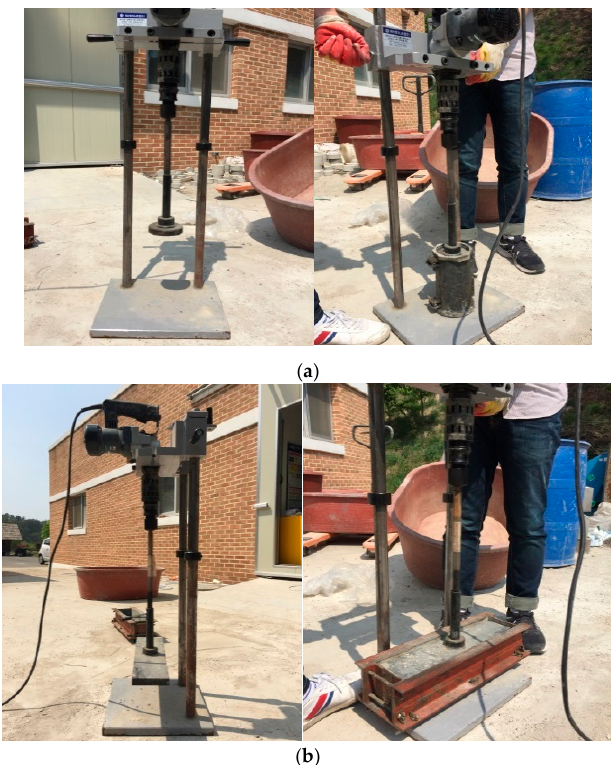
Figure 2. Manufacturing of test specimens. ( a ) Manufacturing of compressive strength specimens; ( b ) Manufacturing of flexural strength specimens.